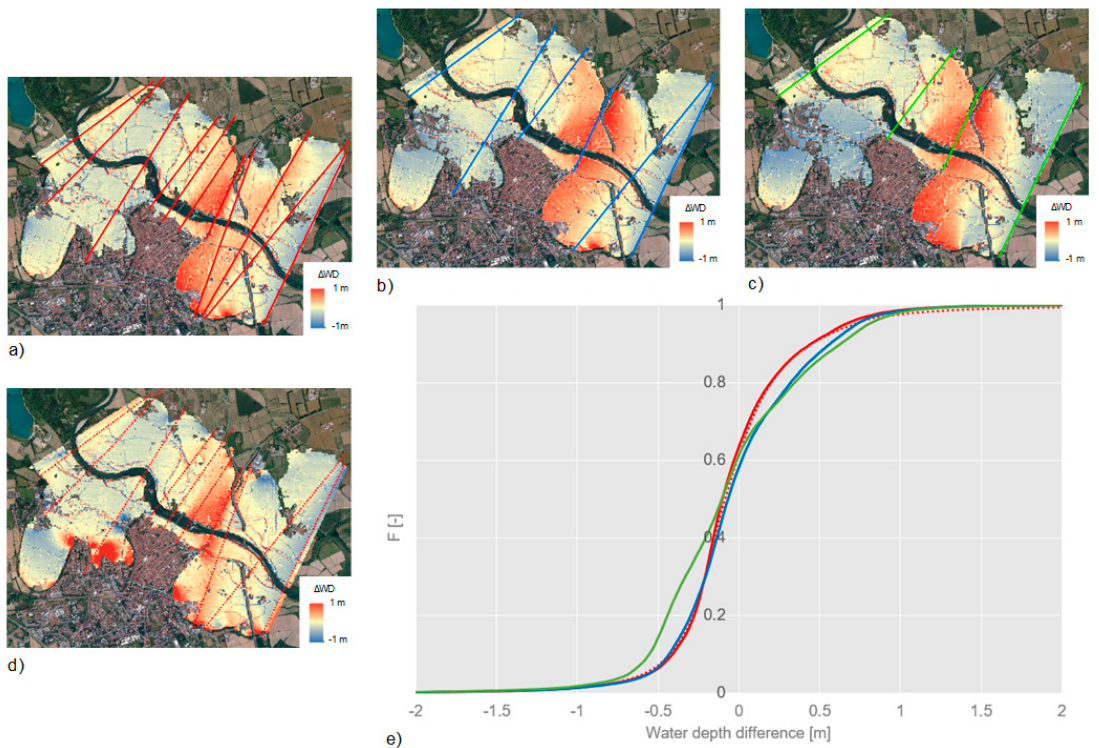
Figure 6. Results for the sensitivity of RAPIDE results to line spacing and use of the mask. Maps of ∆ WD for: ( a ) ‘Narrow spacing’ (red); ( b ) ‘Large spacing’ (blue); ( c ) ‘Very large spacing’ (green); ( d ) ‘Narrow spacing’ without a mask (red dotted); ( e ) Cumulative density functions of ∆ WD for the four cases.